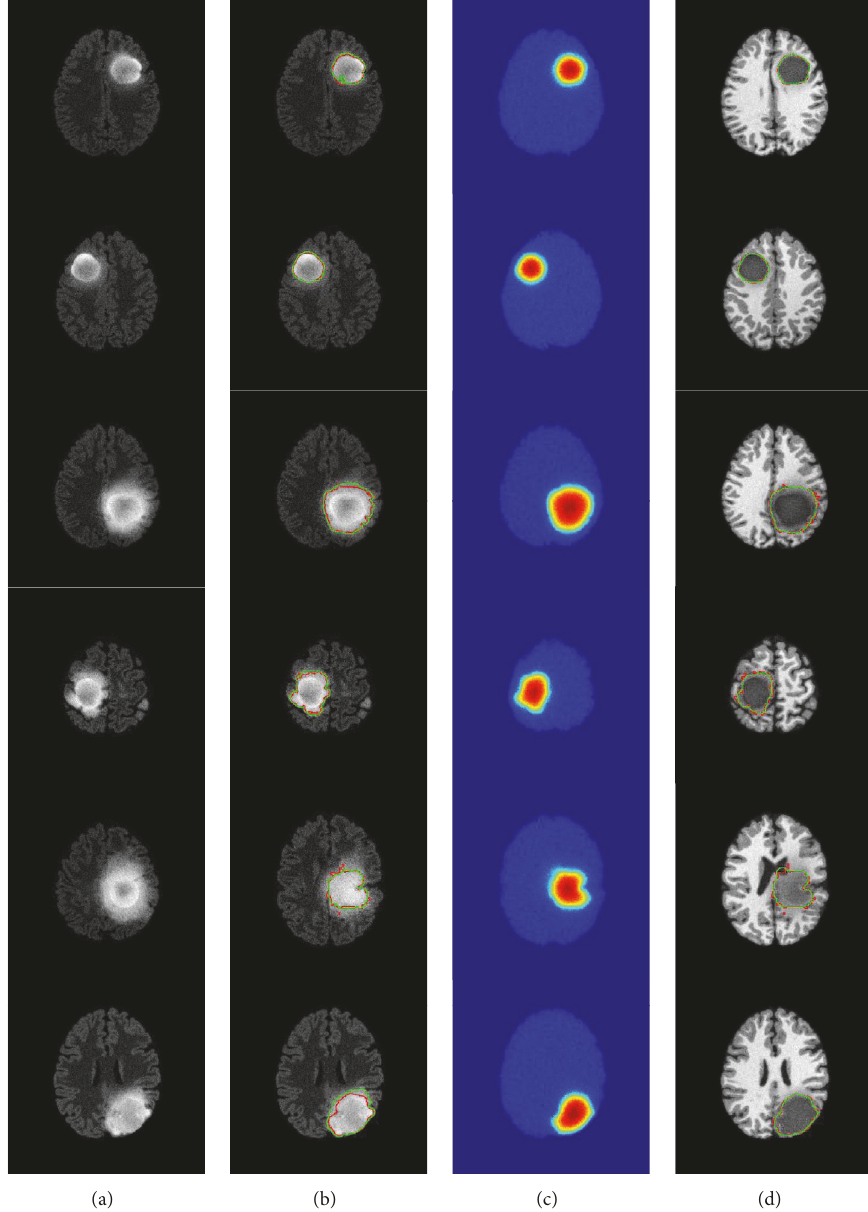
Figure 9: Results of segmentation by level set method in Flair MRI images and the proposed approach applied in six patients taken from BRATS 2012. (a) Flair images (b) segmentation by levelset in Flair images. (c) Temperaturedistribution with noise (d) the segmentationusing the proposed approach showed in T1-weighted images (green: segmentation, red: ground